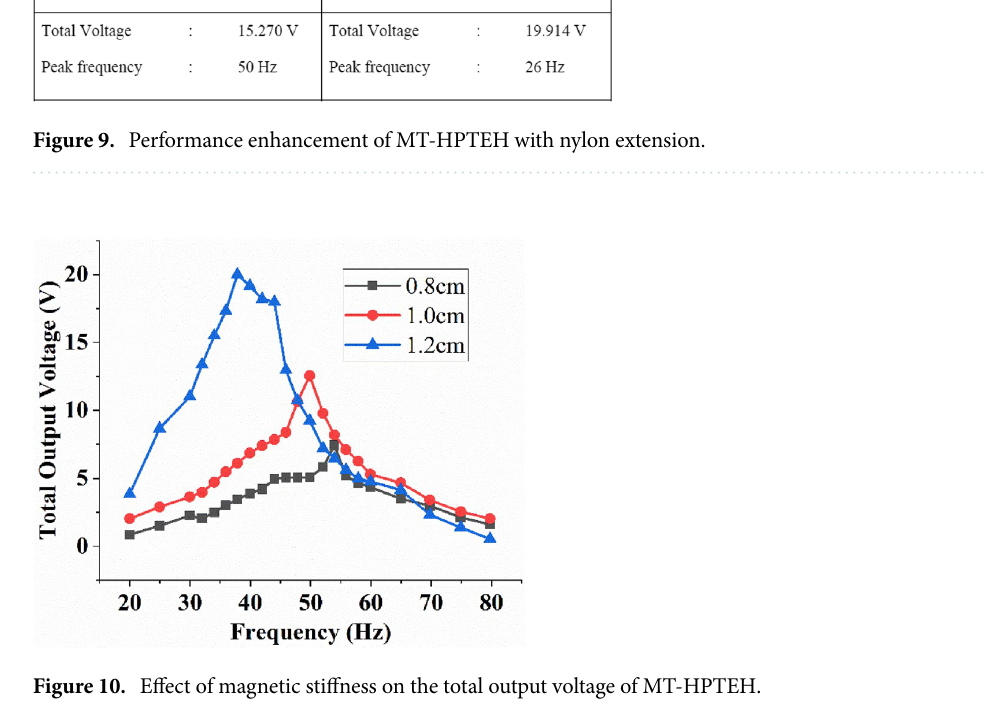
Figure 10. Effect of magnetic stiffness on the total output voltage of